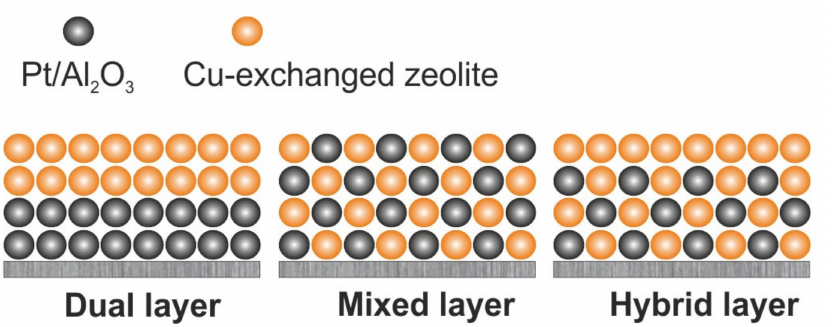
Figure 3. Schematic diagram representing bifunctional ammonia slip catalyst in three different washcoated structured methodologies. Reprinted from [64] with permission from Science